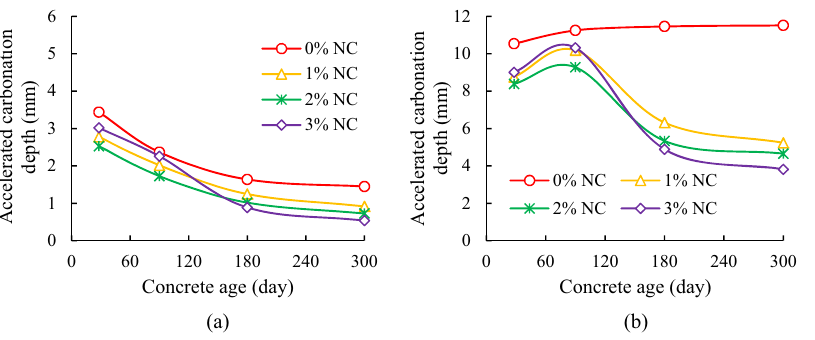
Figure 2: Concrete accelerated carbonation depths with di ff erent levels of NC replacement ( a ) SC concrete ( b ) AC